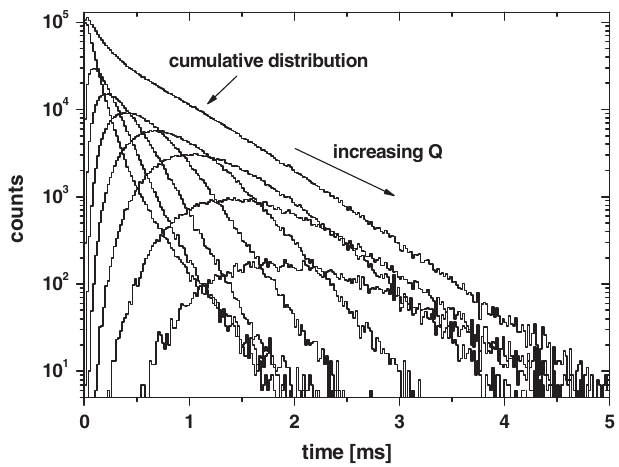
FIG. 9. Distribution of residence times inside the plasma for the different charge states of extracted neon ions from 1 þ to 8 þ and the cumulative distribution. The residence times are deter- mined from the moment of neutral atom ionization until the moment when the ion with the given charge state is lost in the extraction